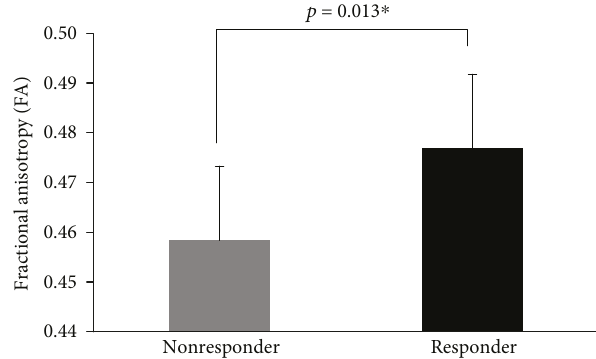
Figure 7: Comparison (mean [SD]) of responder versus nonresponder of CMC in the SM-cTBS group. Error bars represent